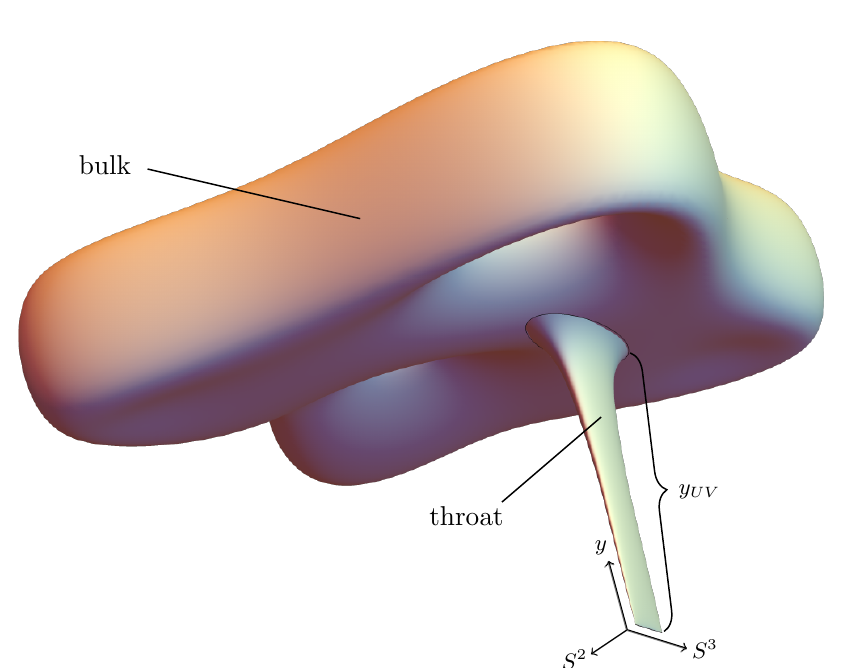
Figure 2 . A sketch of a Calabi-Yau with a KS-throat. At the tip of the throat the S 2 shrinks to zero size while the S 3 remains (cid:12)nite. y UV marks the cuto(cid:11) where the throat meets the